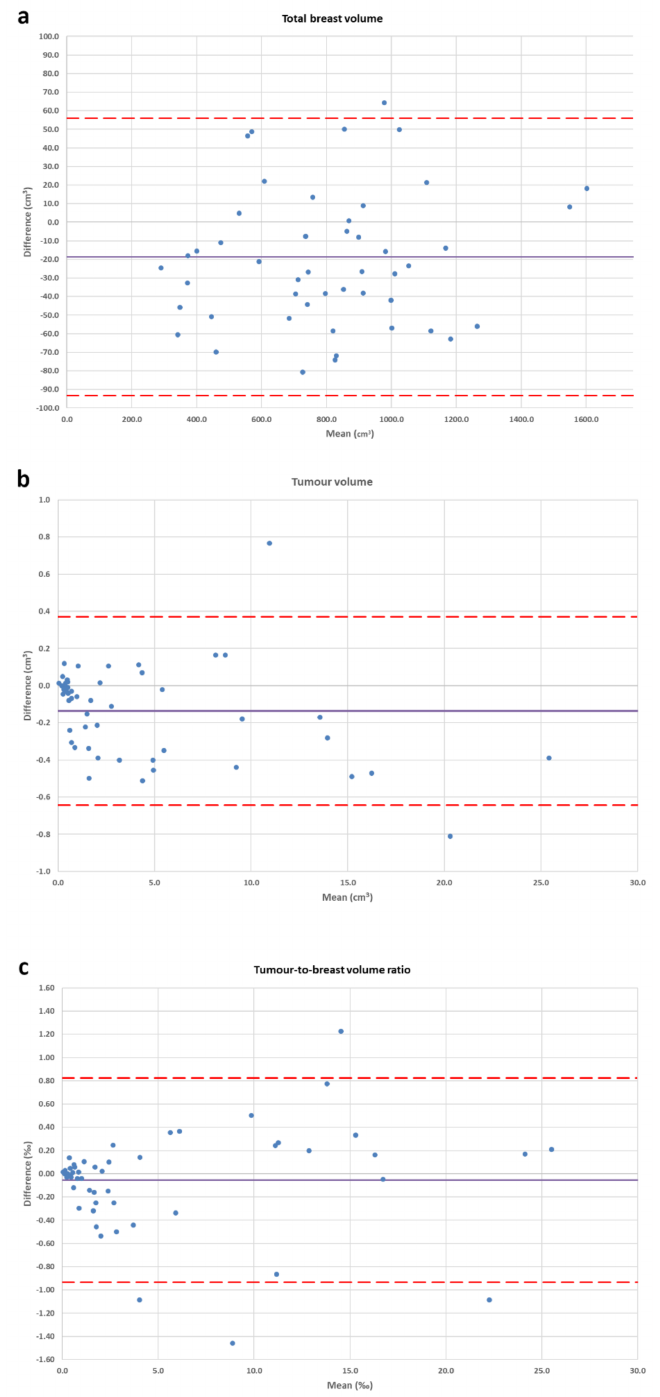
Figure 2. Bland–Altman plots for interobserver reproducibility. The straight and dashed lines represent the bias and its confidence interval, respectively. Blue dots represent the cases. ( a ) Whole breast volume region-growing segmentation; ( b ) fully manual segmentation of the tumour volume; ( c ) tumour-to-breast volume